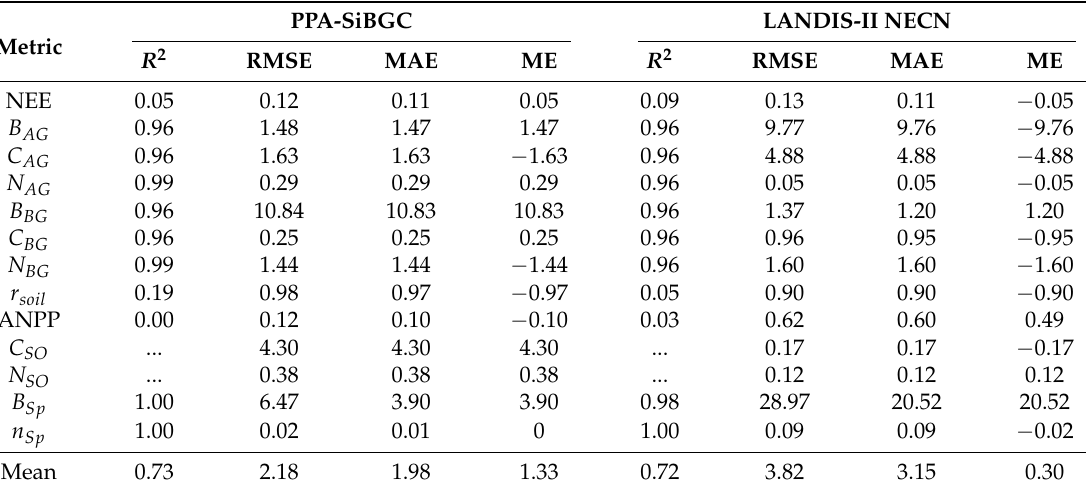
Table 8. Model fitness for